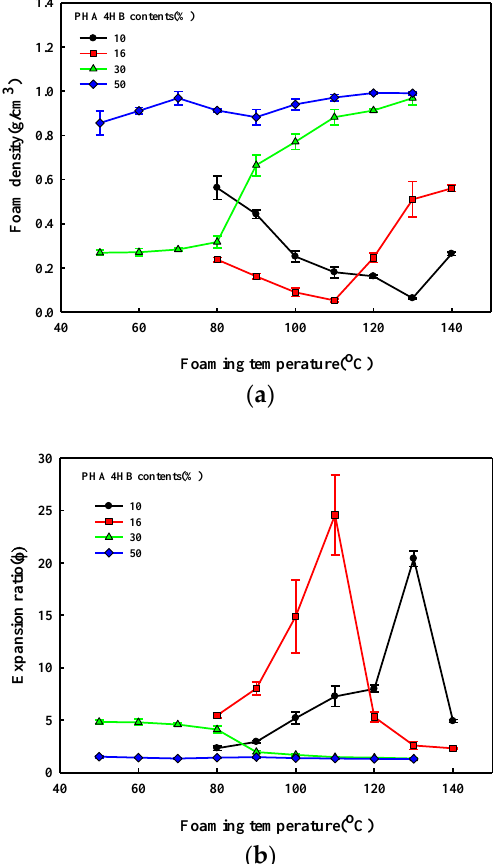
Figure 6. Effect of foaming temperature on the structure of the P(3HB- co -4HB) bead foamed at 90 bar; ( a ) foam density; ( b ) expansion ratio.